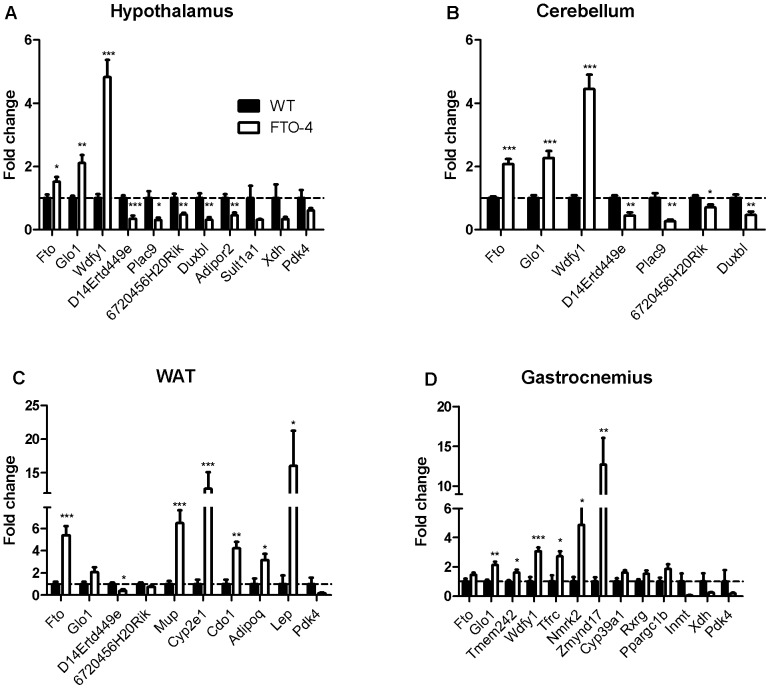
Differences in gene expression between WT and FTO-4 mice based on microarray data.Expression of the indicated genes in the cerebellum (A), hypothalamus (B), WAT (C) and gastrocnemius (D) of wildtype (WT, black bars) and FTO-4 (white bars) mice. Data are expressed as the fold change compared to wildtype. Significance was tested using Student's t-test to compare FTO-4 to WT. ***p<0.001, **p<0.01, *p<0.05.